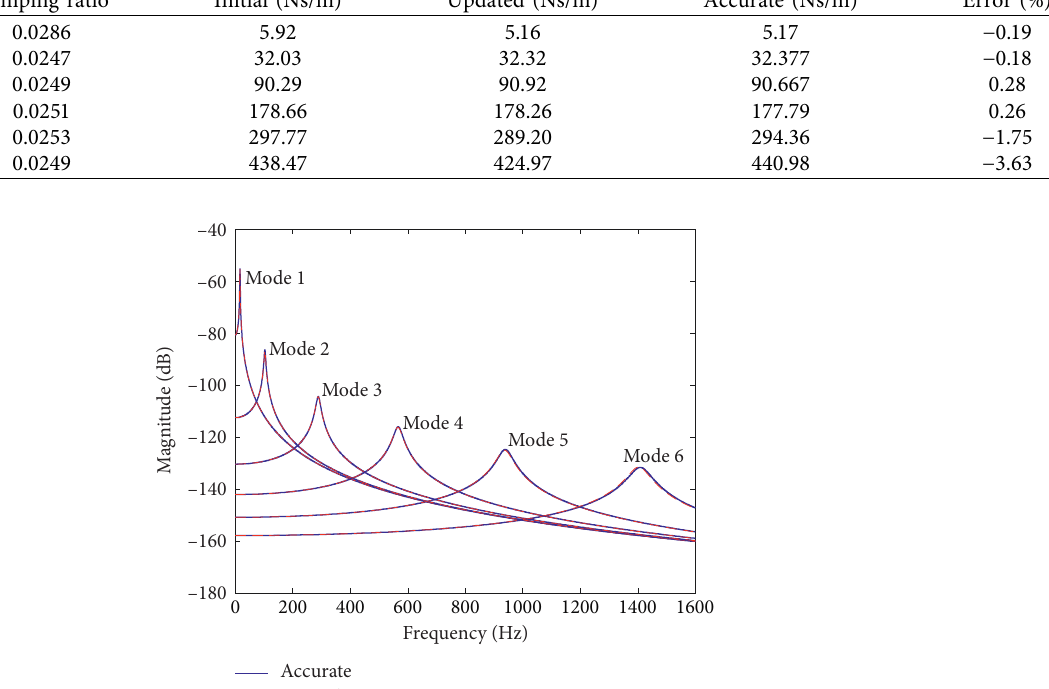
Table 7: Comparison of the diagonal elements of the modal damping matrix before and after updating for case 2. Mode Damping